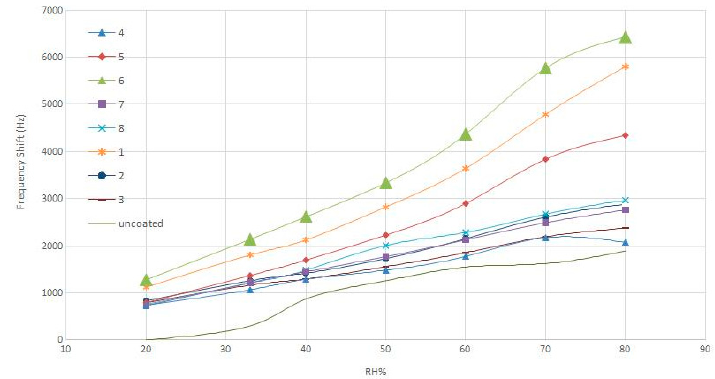
Figure 7. Sensitivity of all AgNW-based SAW sensors against humidity.